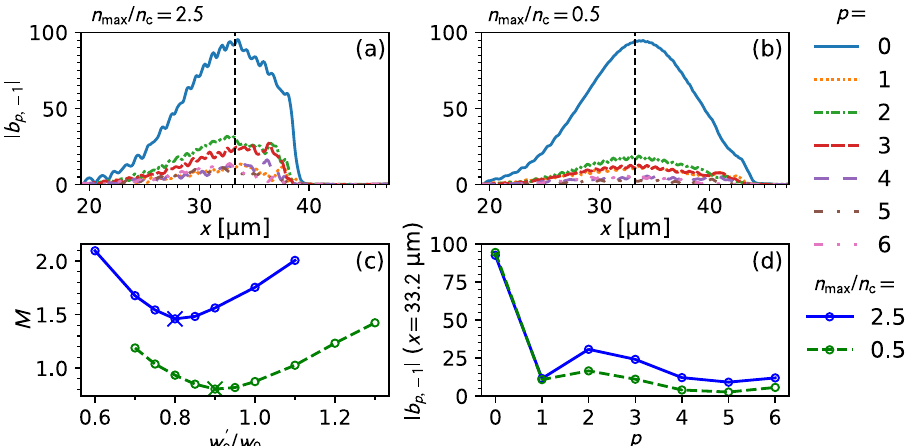
that sets the characteristic transverse scale in the 0